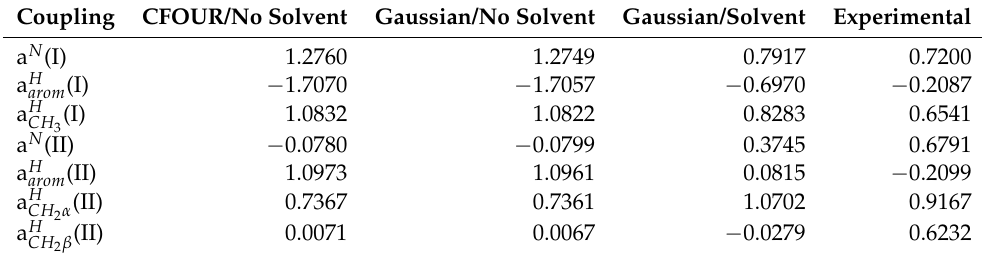
Table 5. DMeAzetA hfccs (mT) comparison between CFOUR without solvent, Gaussian without solvent, and Gaussian with solvent. Experimental results are provided as reference. Coupling CFOUR/No Solvent Gaussian/No Solvent Gaussian/Solvent